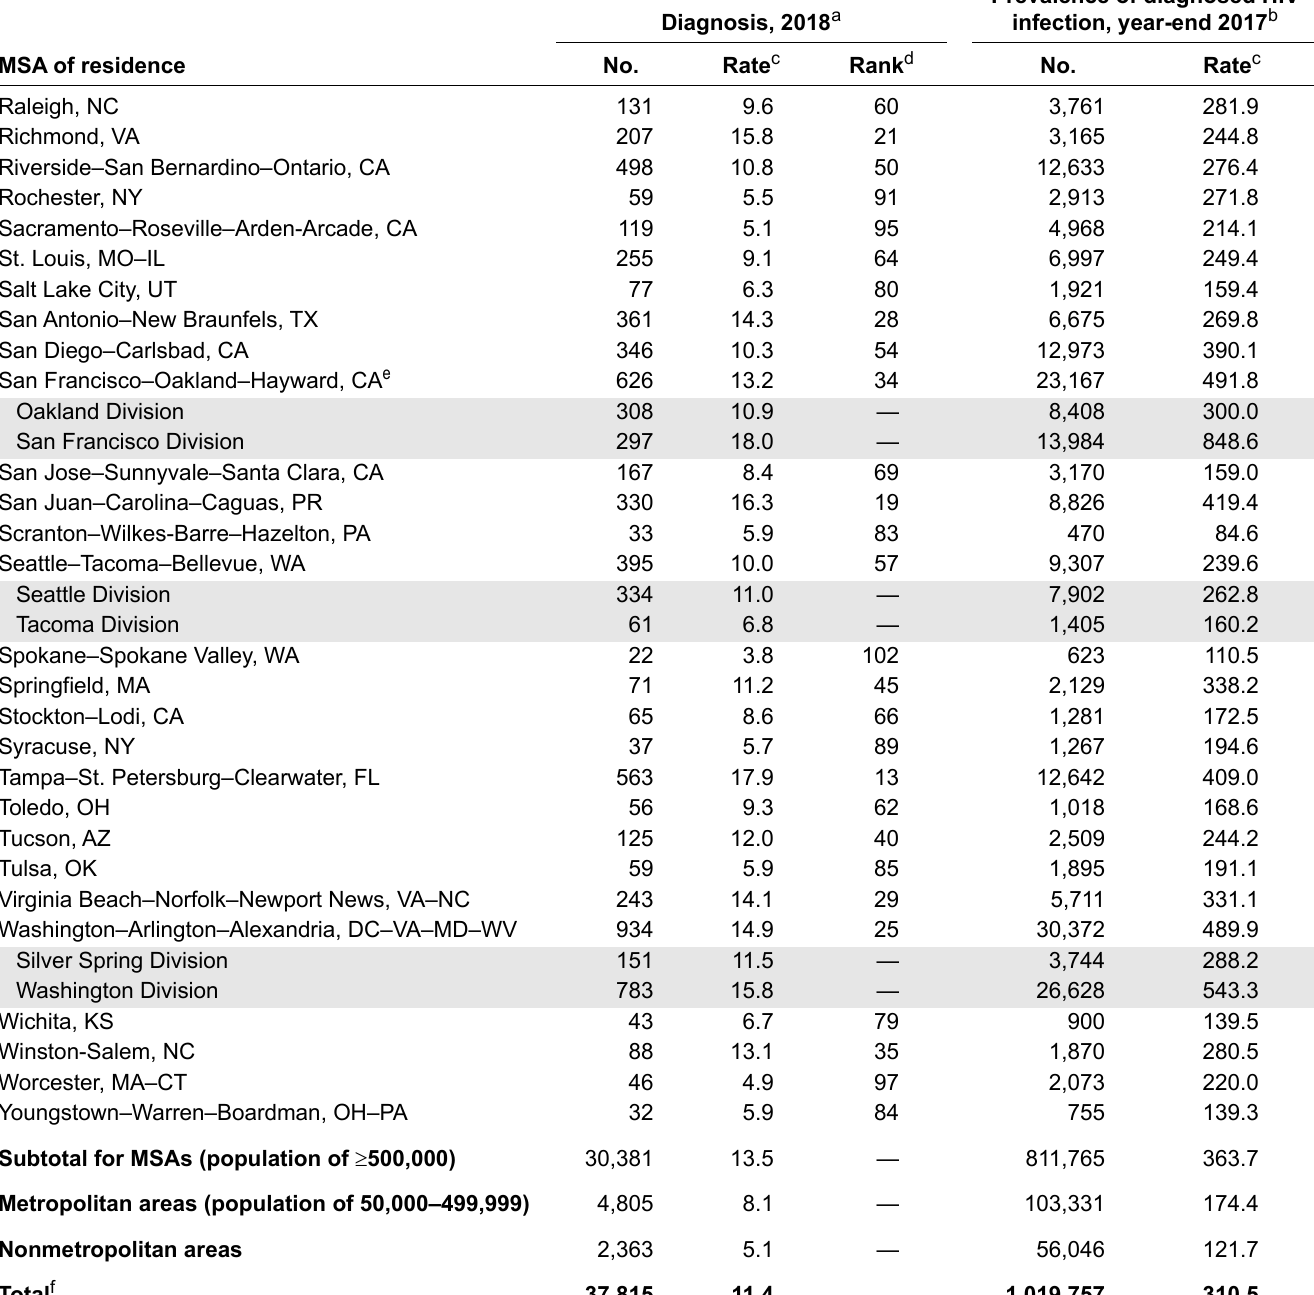
Table 30. Diagnoses of HIV infection, 2018, and persons living with diagnosed HIV infection (prevalence), year- end 2017, by metropolitan statistical area of residence—United States and Puerto Rico